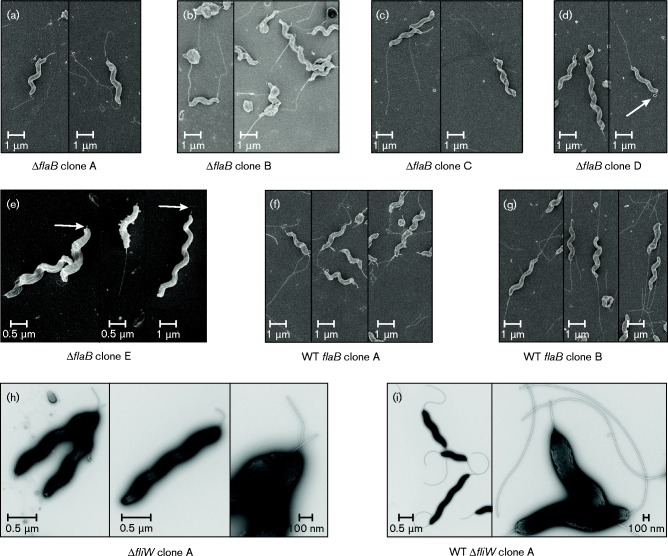
EM analysis of the flagellar structure in flaB (CJM1_1294) and fliW (CJM1_1052) gene deletion mutants. Scanning EM was used to assess the flagellar structure in flaB (CJM1_1294) mutant clones A–E (a–e) and coupled WT clones A and B (f, g) and transmission EM was used for analysis of the fliW deletion mutant clone A (h) and its parental WT (i). (a–c) The motile (clones A and B) and intermediate motility (clone C) flaB (CJM1_1294) mutants harboured bipolar flagella. (d, e) Non-motile flaB clones D and E lack flagellar structures at both poles; a protruding structure (flagellar filament or hook-like structure) was observed (indicated with white arrows), or rarely bacteria were observed that harboured a flagellar structure at a single pole as shown in the right panels of (d) and (e). (f, g) Motile WT isolates (clones A and B) coupled to flaB mutants displayed flagellar structures at both poles. (h) No flagellar filaments were observed for the non-motile fliW deletion mutant clone A; however, short hook-like structures were observed. (i) The WT isolate coupled to the fliW mutant clone A possessed flagellar structures at both poles.